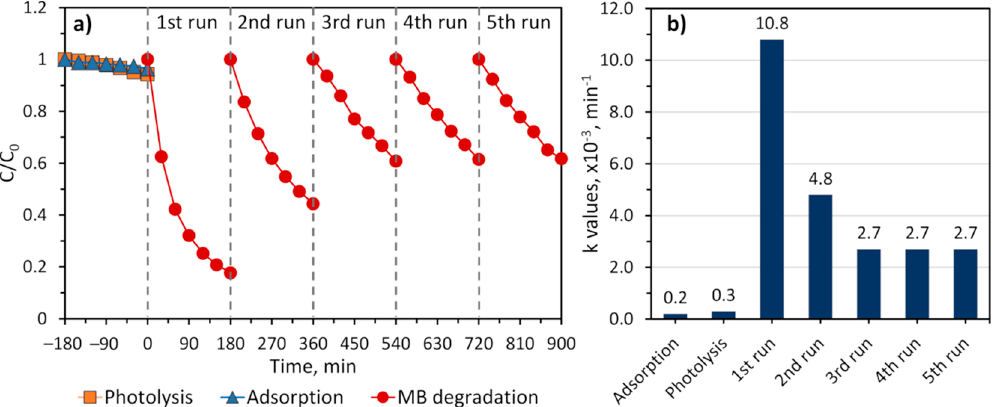
Figure 4. ( a ) Effect of cycling runs on photocatalytic degradation of MB dye in the presence of HDPE-TiO 2 under UV-B irradiation and ( b ) rate constants of photocatalytic degradation.